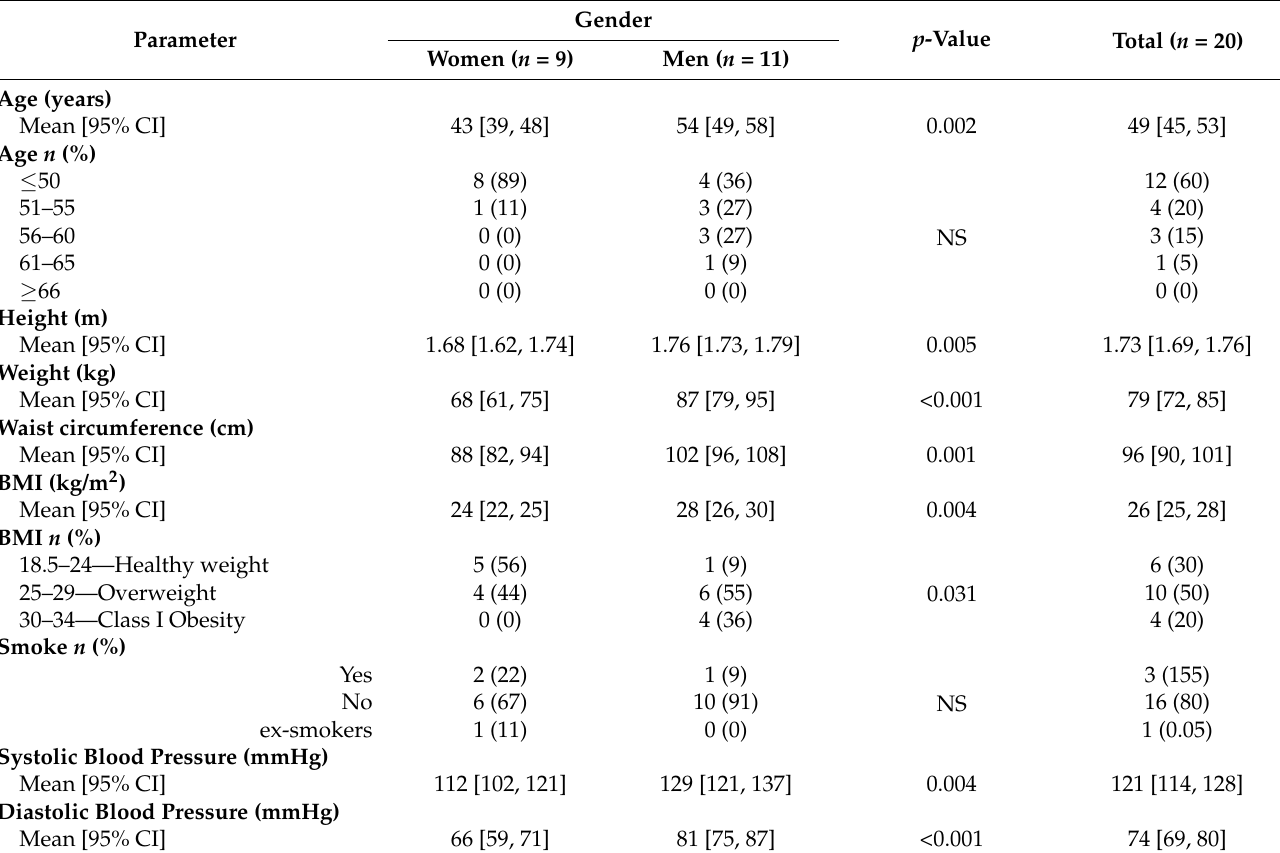
Table 1. Demographic data of healthy volunteers at enrollment ( n =